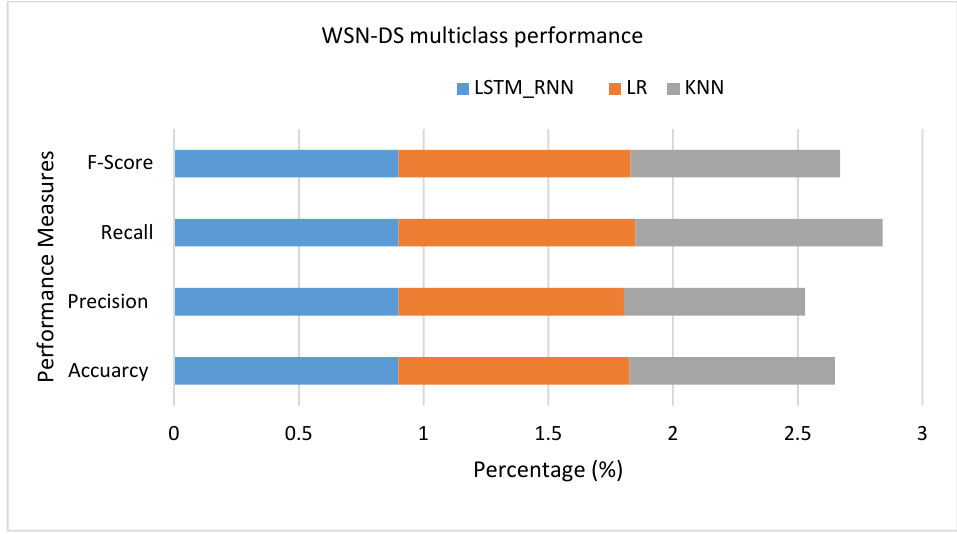
Figure 22. WSN-DS Multiclass classification performance.